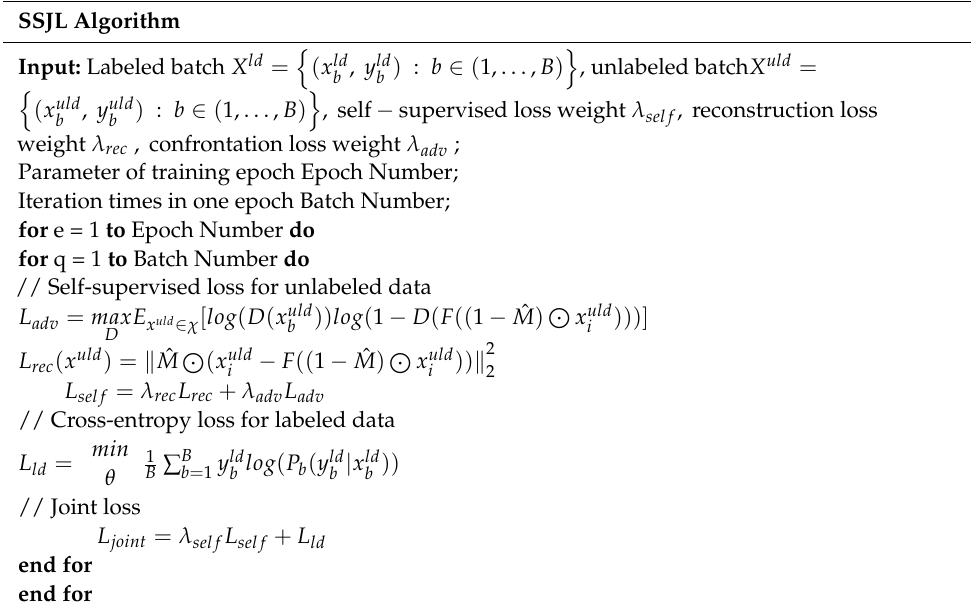
Algorithm 1. Training procedures of the SSJL